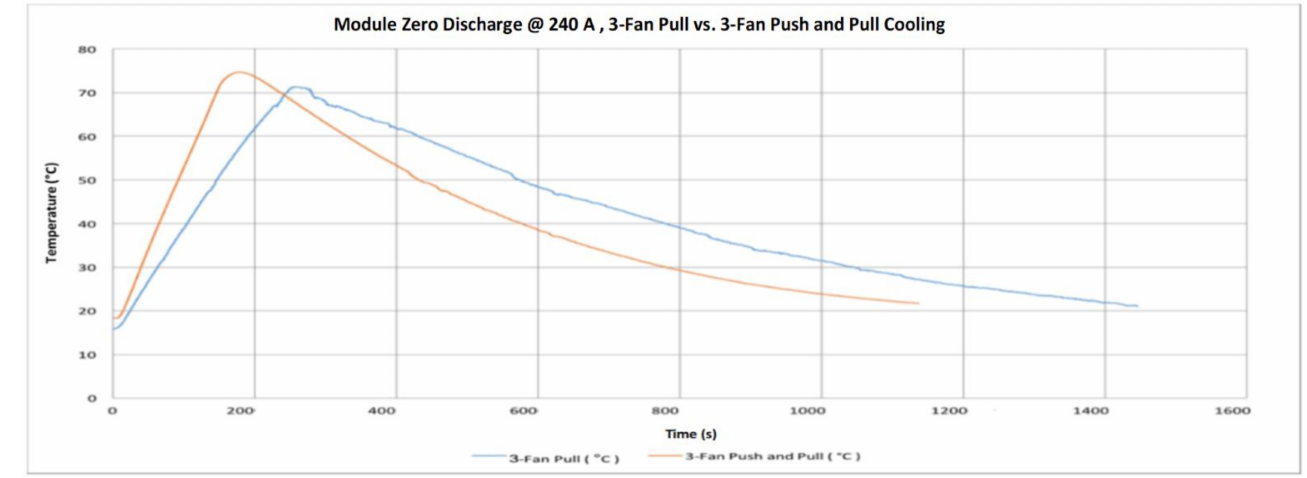
Figure 16. Module zero discharge, 240 A 3-fan pull vs. 3-fan push and pull